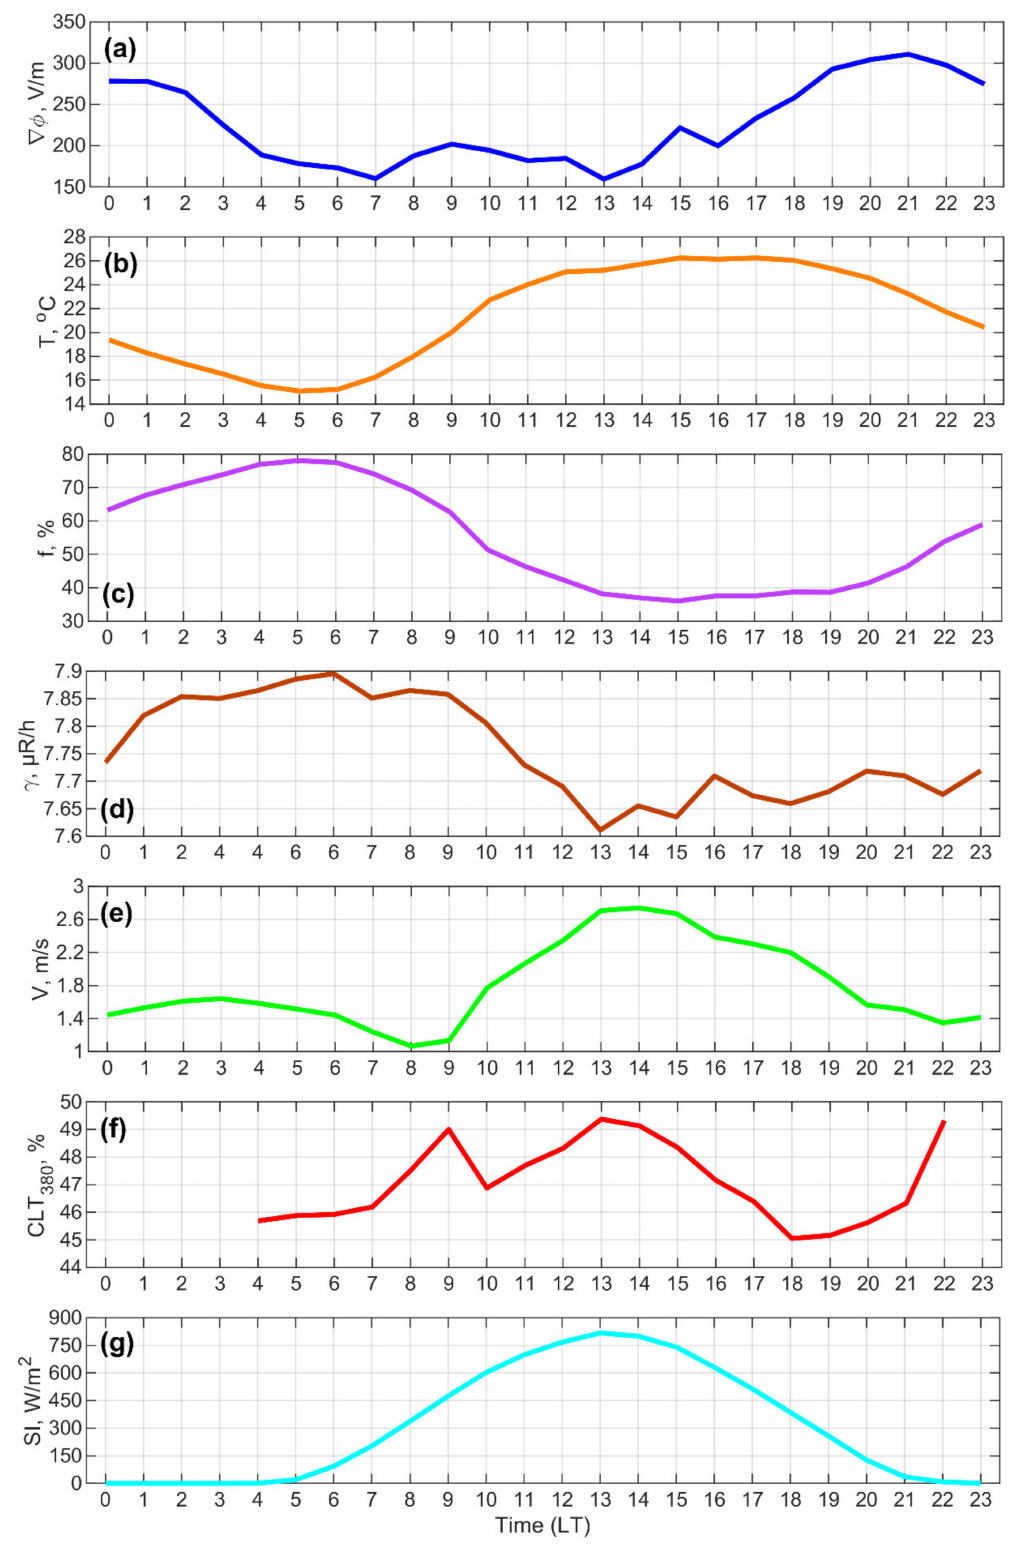
Figure A3. Variations in hourly averages of the potential gradient ( a ), air temperature ( b ), relative humidity ( c ), gamma radiation ( d ), wind speed ( e ), atmospheric transparency at 380 nm ( f ), and solar irradiance ( g ) under fair-weather conditions during July in Tomsk according to data from the IMCES GO for